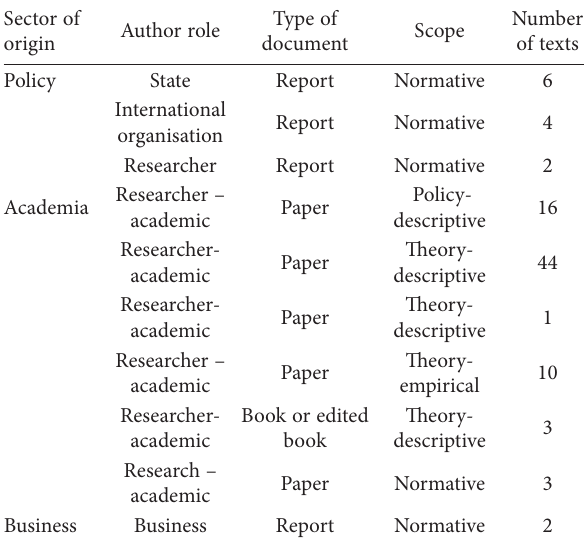
Table 1. Bioeconomy literature used in the paper. Sector